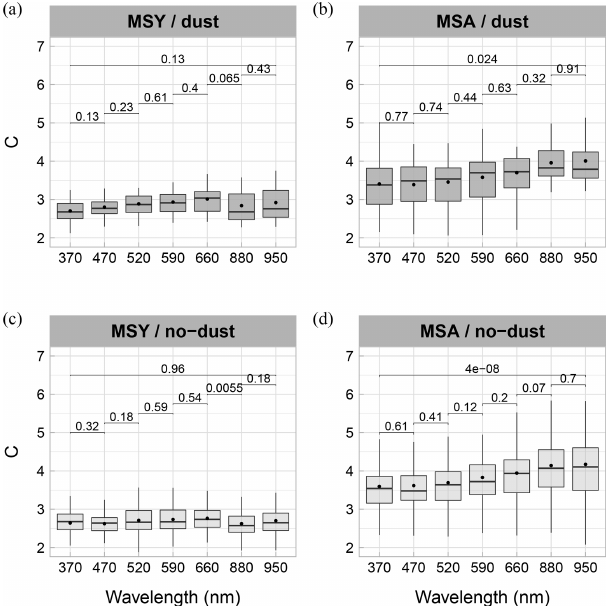
Figure 6. Wavelength dependence of C at MSY (a, c) and MSA (b, d) obtained comparing b atn from the AE33 measured at each wave- length and b abs interpolated and extrapolated to the same wave- length from PP_UniMI. Box plots have been obtained as in Fig. 3 and separated into two categories depending on whether Saharan dust outbreaks took place (dust) or not (no-dust). As in Fig. 3, the values above the box plots between adjacent wavelengths and be- tween 370 and 950nm wavelength box plots show the obtained p values, with p < 0 . 05 meaning a statistically significant differ-